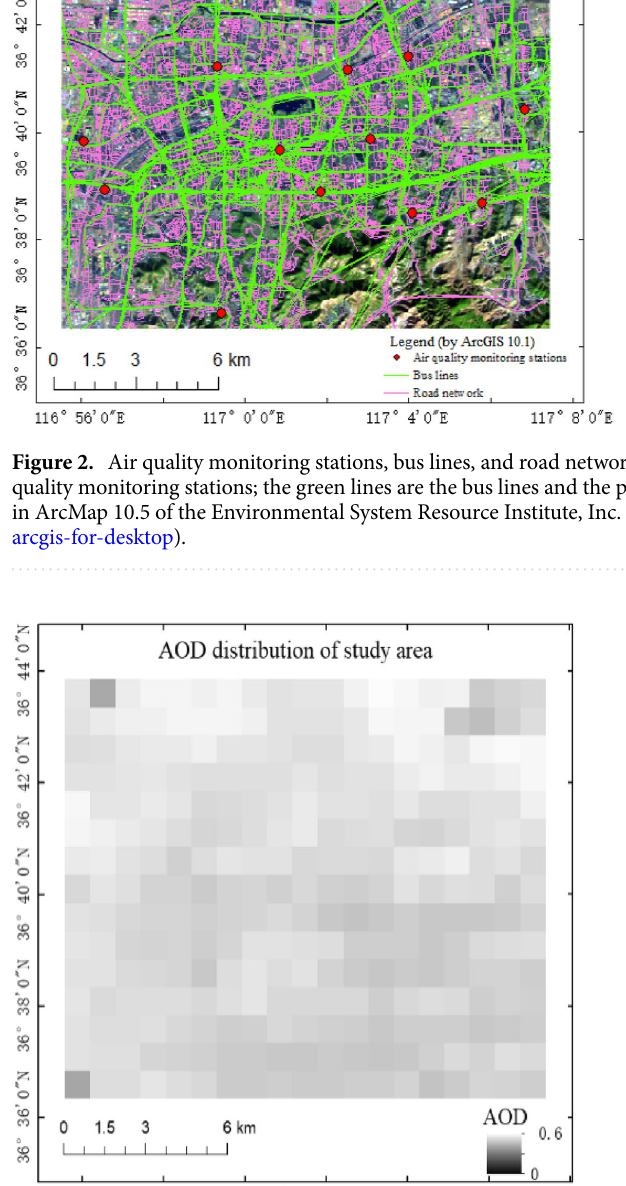
Gridding. Using the gridding tool, the study area was divided into 1 km × 1 km grids, with less than 1 km remaining on the northern and eastern sides of the study area being excluded from the gridding. The AOD, road network density, road area ratio, and number of intersections in each grid were calculated. GWR‑based analysis of the impact of the road network traffic characteristics on the urban air quality. Geographically weighted regression (GWR) is a spatial analysis technique that is widely used in geography and related disciplines involving the analysis of spatial patterns, and it can be used to quantify spatial